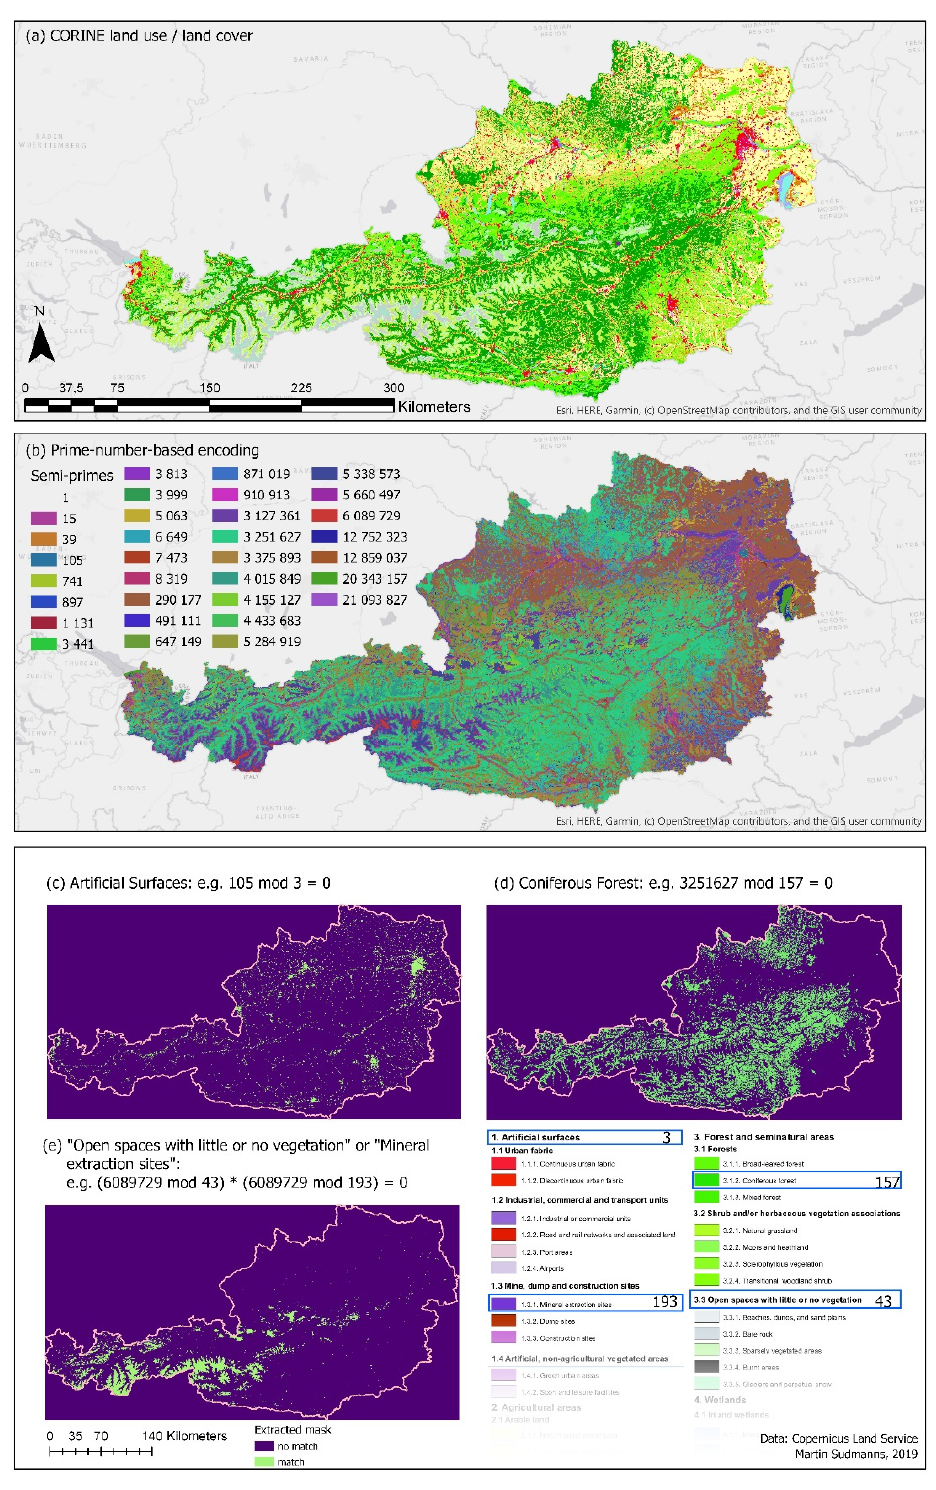
Figure 4. Encoding the hierarchical legend of CORINE land use / land cover of Austria using prime numbers. ( a ) Shows the original CORINE layer as a reference; ( b ) shows the same dataset using the prime-number-based encoding. This illustration is not interpretable but not intended for visualisation and depicted for illustration purposes only. ( c – e ) show three selected masks, which were decoded from the encoded dataset. Although labels from di ff erent hierarchy levels are used, the schema of the dataset does not need to be known as the masks can be recovered using a modulo